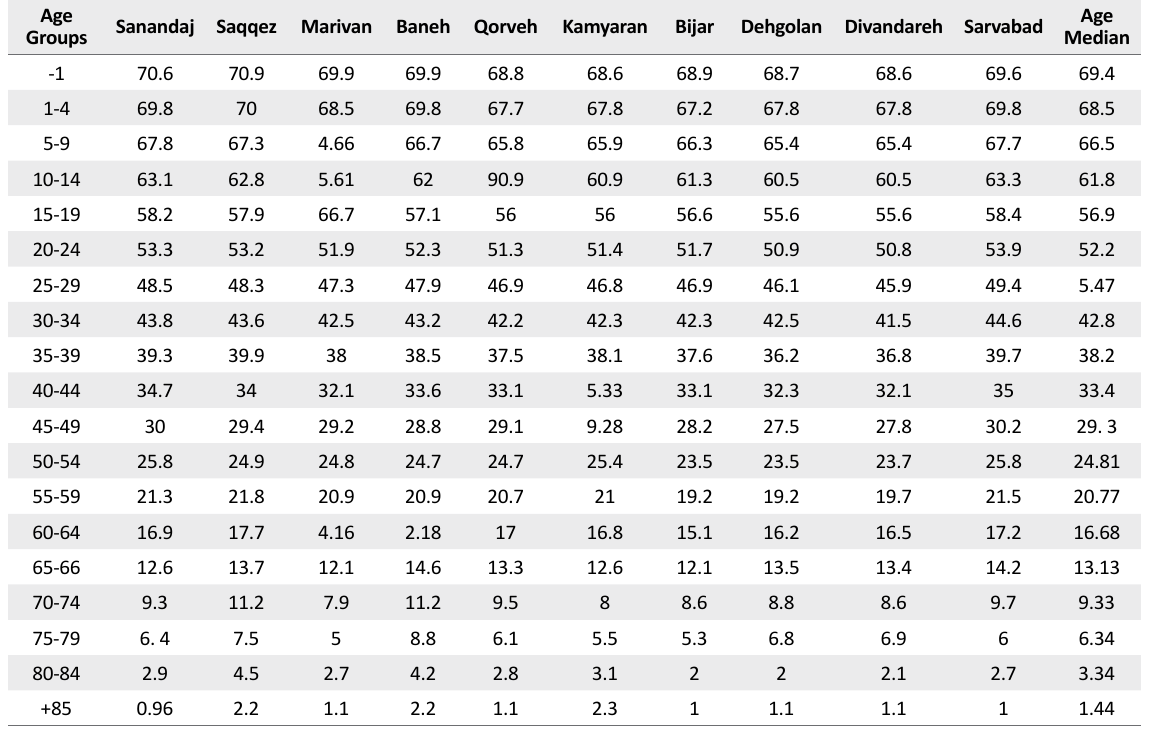
Table 1 . Life expectancy at birth (y) for males in ten towns of Kurdistan Province, 2013 Age